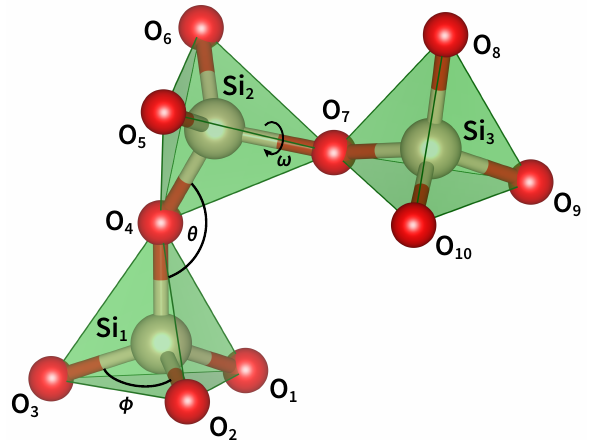
Figure 2. Parameters defining the topology of silica. The angle φ corresponds to the O–Si–O bond angle, θ corresponds to the Si–O–Si bond angle, while ω is the dihedral angle between the planes formed by atoms O–Si–O and